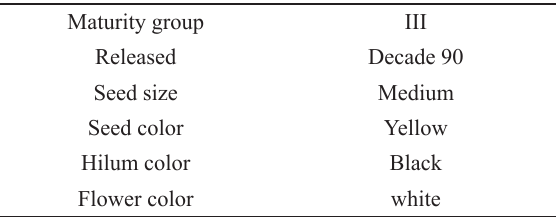
Characteristics of Fe